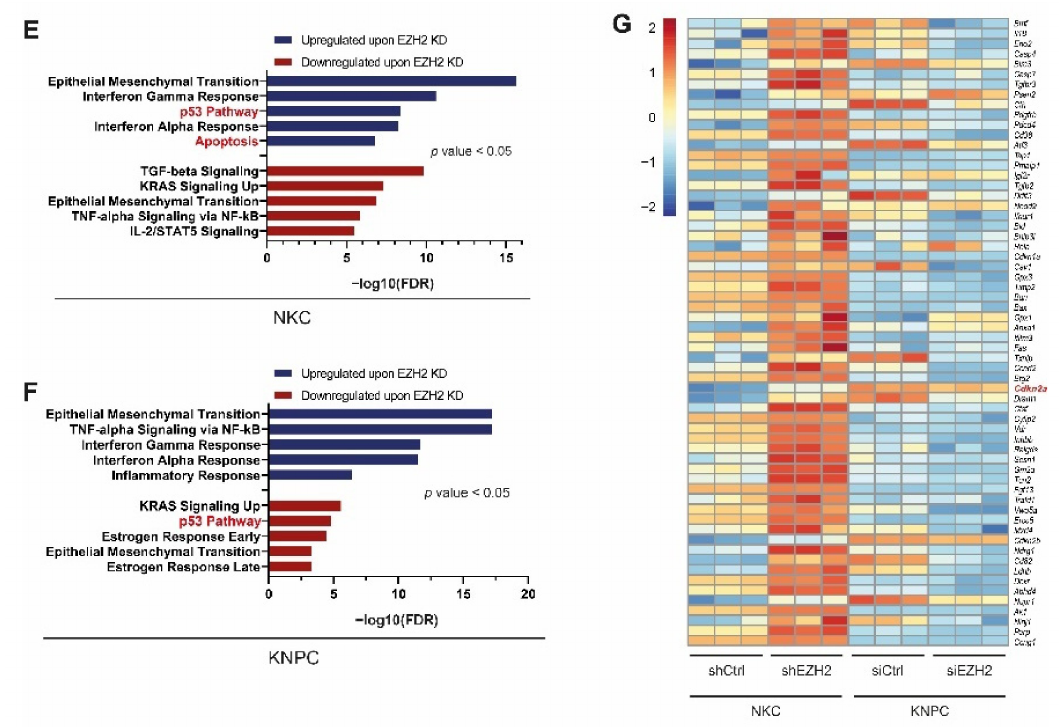
Figure 2. TP53 -status determines EZH2-dependent target gene regulation. ( A , B ) Heatmap illustrating expression of genes with significant upregulation (FPKM > 0.01, log2FC > 0.5, q < 0.05) upon knockdown of EZH2 in the indicated p53wt cells ( Kras G12D (KC): 384 upregu- lated genes) and caNFATc1;Kras G12D (NKC): 1322 upregulated genes) and its consequences on the expression of these genes in the respective p53mut cells ( Kras G12D ;Trp53 R172H/+ (KPC) and Kras G12D ;caNFATc1;Trp53 R172H/+ (KNPC)). ( C , D ) Gene set enrichment analysis (GSEA) in the indicated p53wt ( C ) and p53mut ( D ) PDAC cells comparing the enrichment of ‘favorable prognosis’-associated genes (Supplementary Table S8) [45] upon knockdown of EZH2 after RNA-sequencing. Normalized enrichment score (NES) and (false discovery rate) FDR as indicated in the graph (GSEA of NKC as previously shown in [13]). ( E , F ) Gene ontology (GO) analysis to reveal significantly up- or down- regulated pathways upon EZH2 depletion in the indicated PDAC cells ( p < 0.05). ( G )